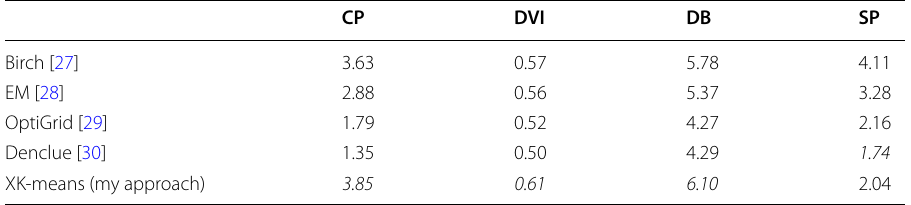
Table 11 Comparison of the compactness of the clustering methods with the K-Means